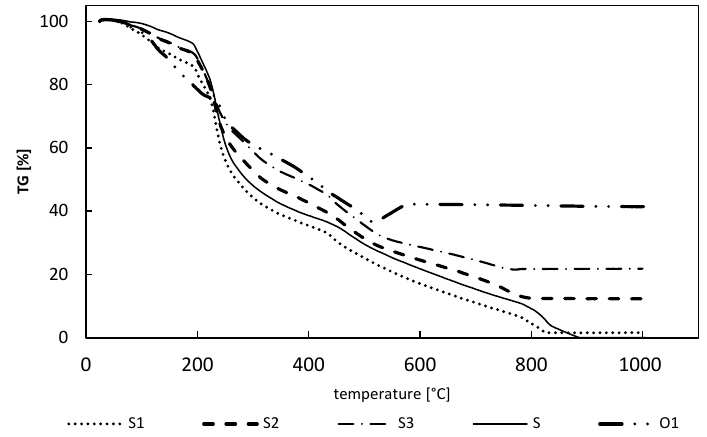
Figure 2. Thermogravimetric (TG) profiles of the hybrid gel beads (S1, S2, S3), pectin-only gel beads (S), and PB powder (O1).